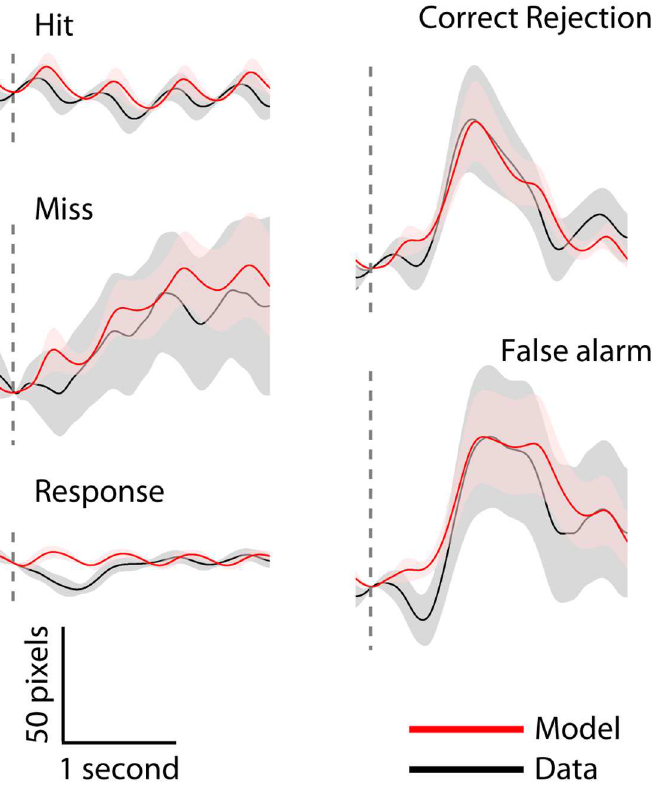
Fig 2. Phasic pupillary responses. Trial-averaged modeled(red) and empirical (black) stimulus-related pupil dilations. The vertical dashedline represents event (stimulus or response) onset. Error bars represent the